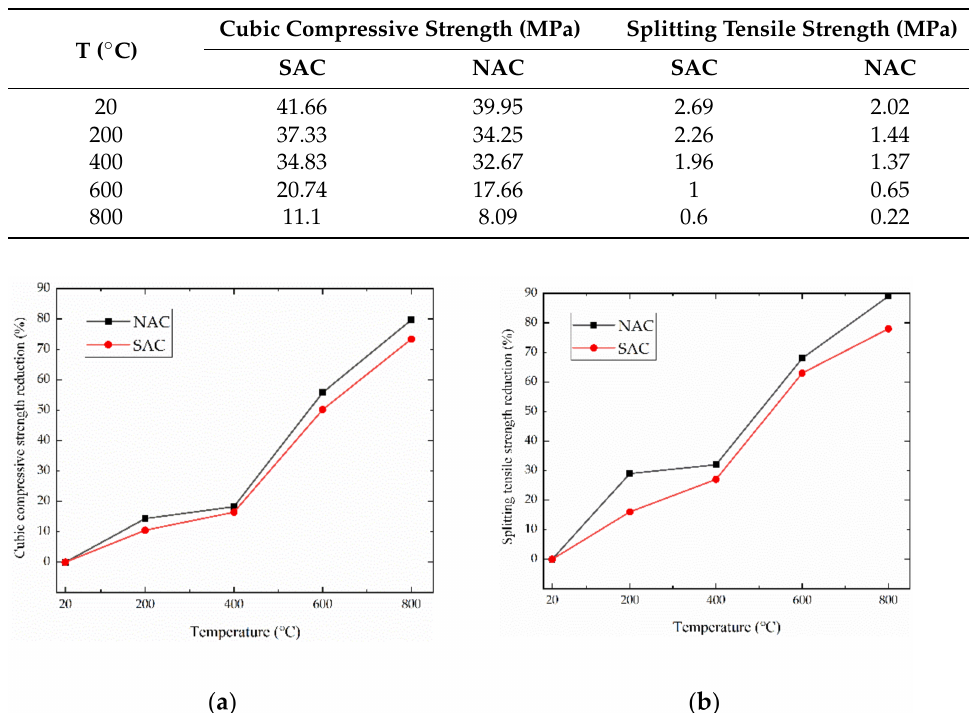
Table 1. Strength of concrete after different temperatures.